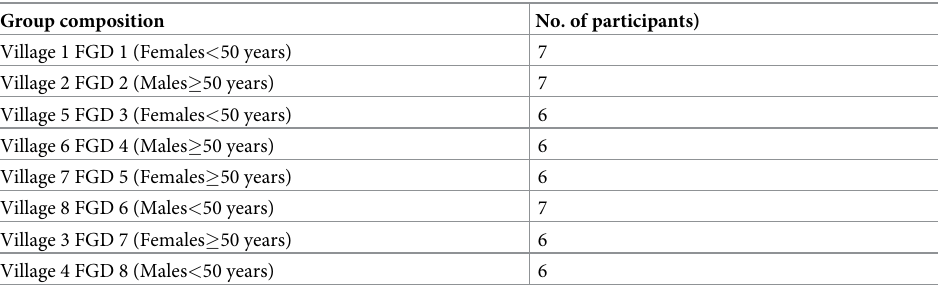
Table 1. Focus group discussion participant characteristics.